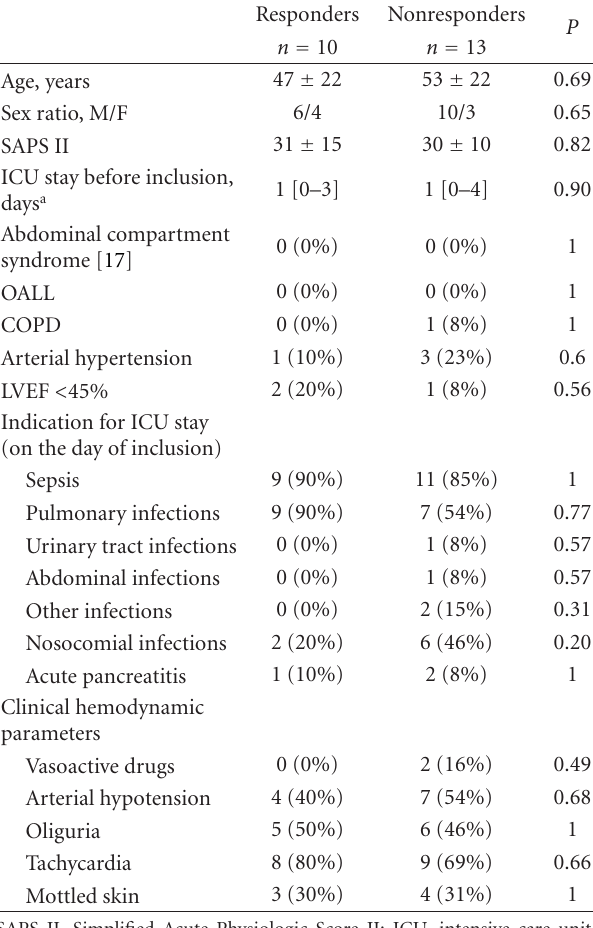
Table 3: Descriptive clinical data of the patients. Table 4: Hemodynamic parameters before and after volume expan- sion in responders and